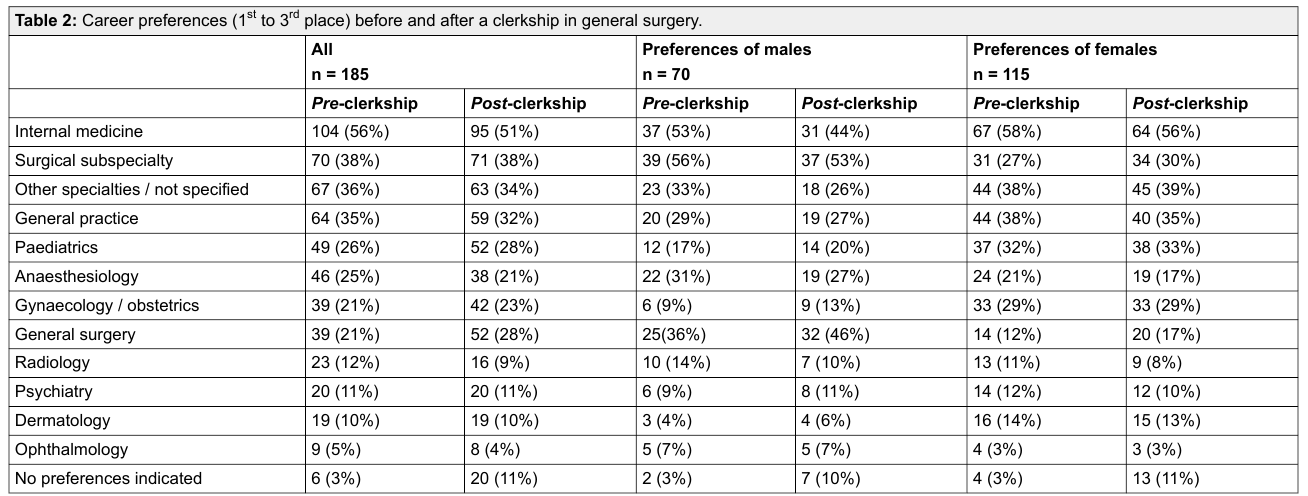
Table 2: Career preferences (1 st to 3 rd place) before and after a clerkship in general surgery.